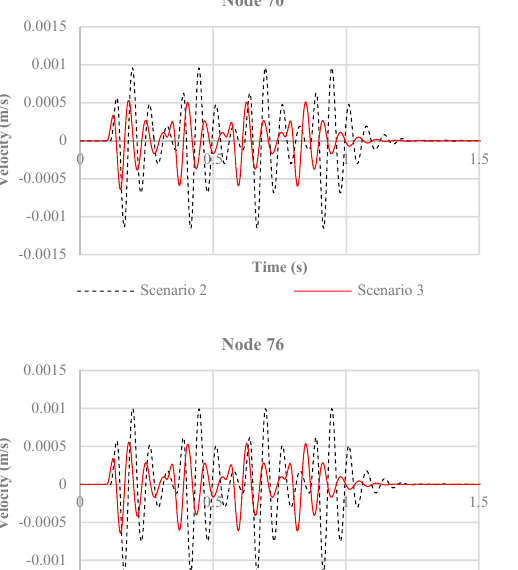
Figure 10. Comparison between the two excavation techniques in terms of ( a ) horizontal velocity in the x direction ( b ) horizontal velocity in the y direction ( c ) vertical velocity of the control point. Table 4. Values of peak component particle velocity in the vertical direction ( pcpv 0 ) obtained in node 45 and comparison with the peak component particle velocity in the limit ( pcpv lim ).